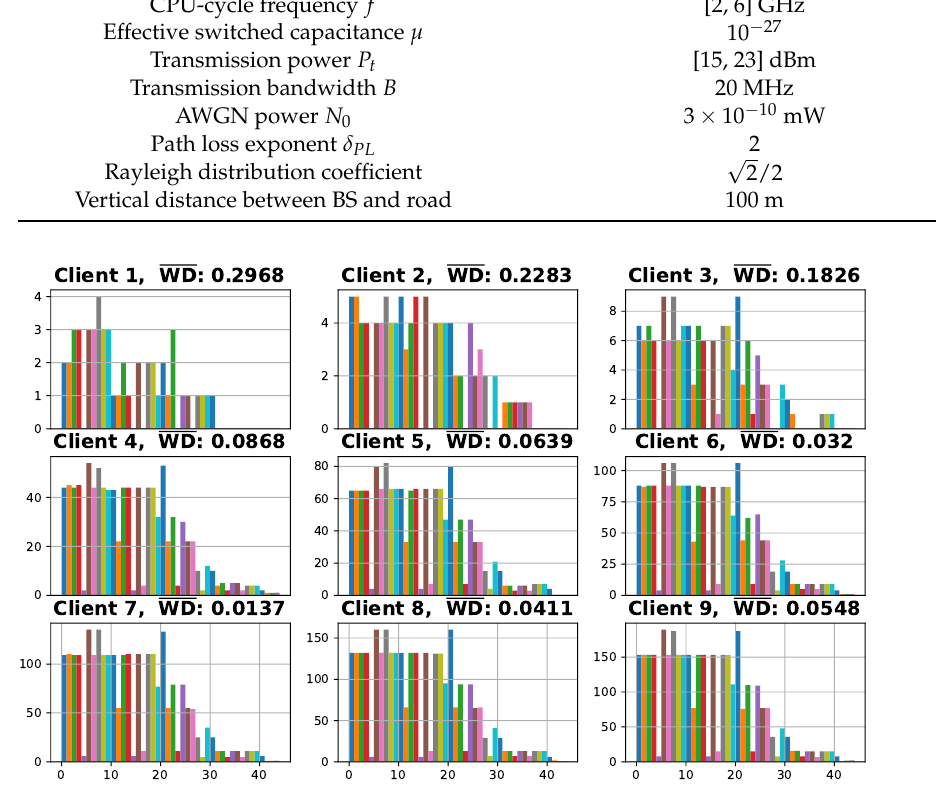
Figure 4. Distribution of local